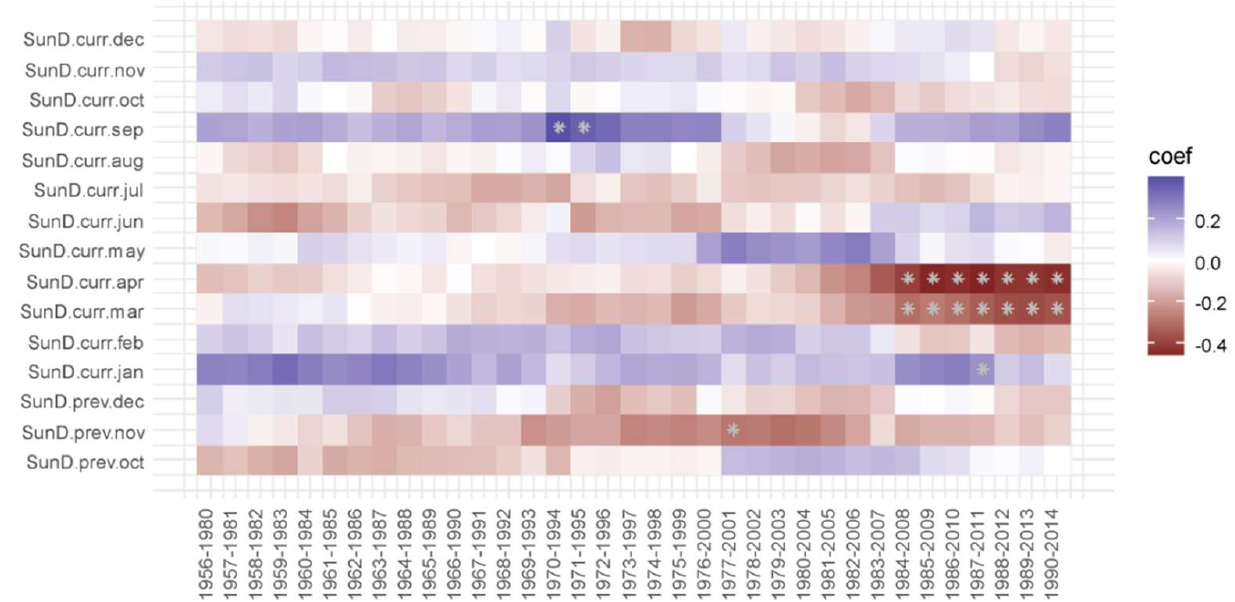
Figure 4. Moving correlation coefficients between tree-ring chronology and precipitation; prev. and curr. indicate previous and current years; * indicates significance at 0.05 level.